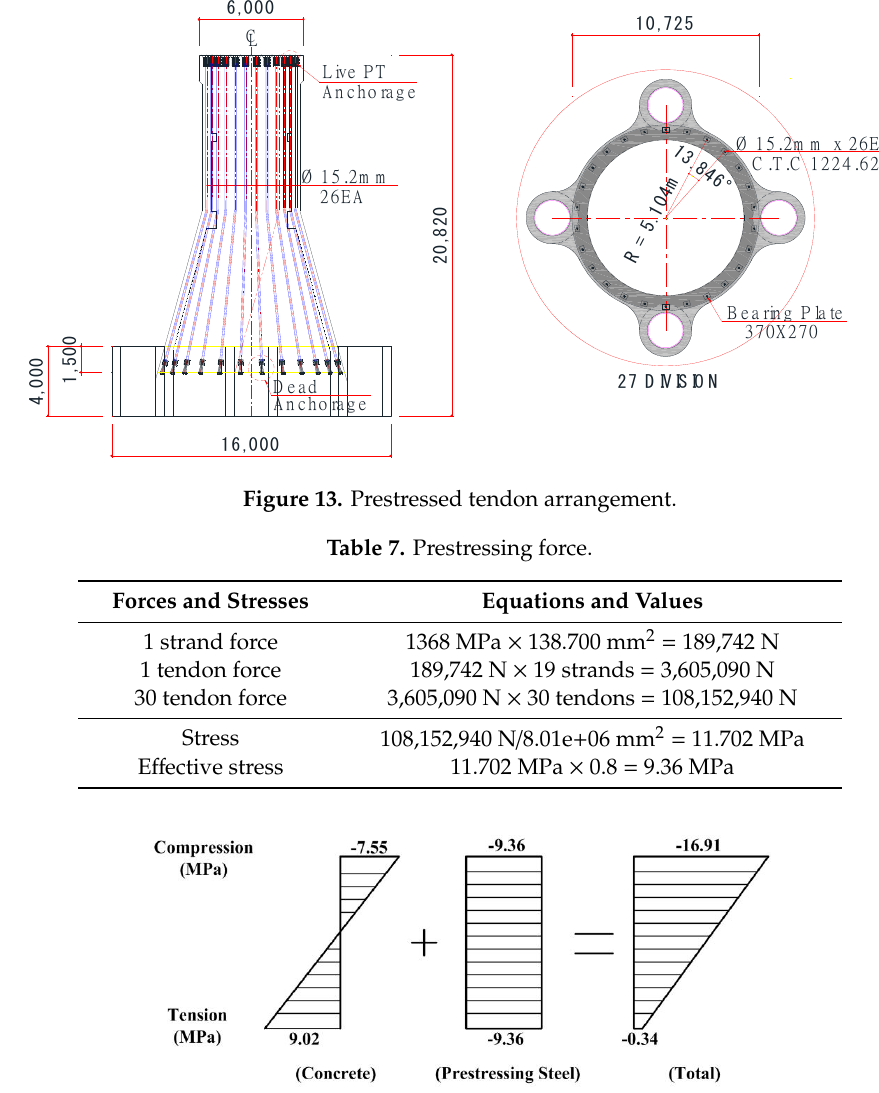
Figure 13. Prestressed tendon arrangement.